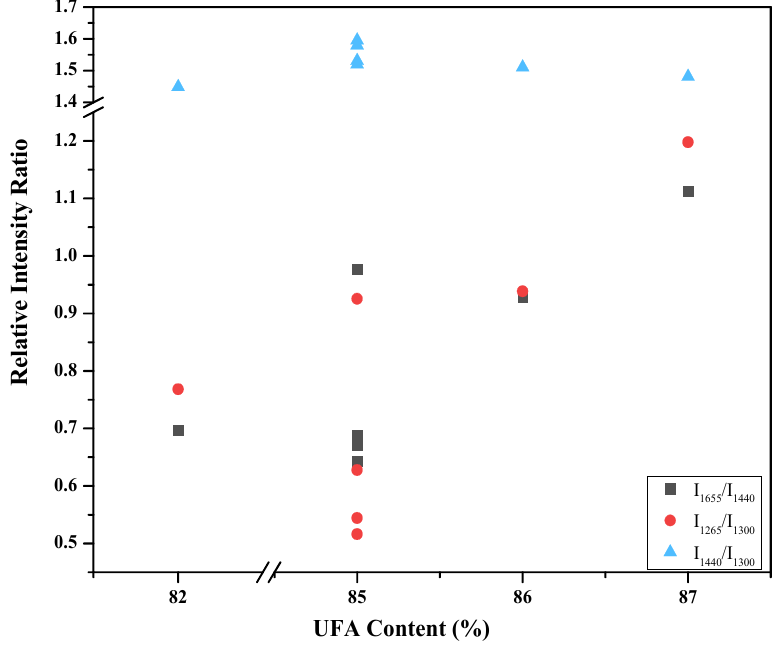
Figure 2. Relative intensity ratios of I 1655 / I 1440 (square), I 1265 / I 1300 (dot), and I 1440 / I 1300 (triangle) as a function of the total unsaturated fatty acid (UFA) content. The error bars of the relative intensity ratios were estimated to be about 10%, mainly caused by baseline corrections.